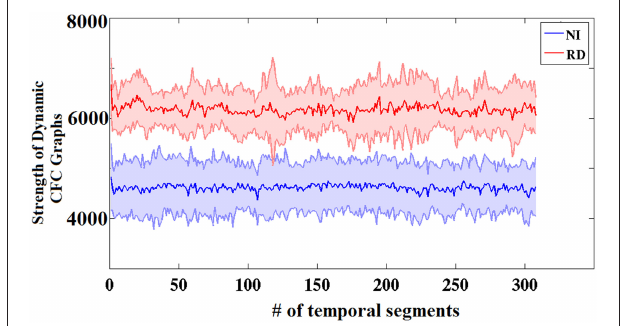
FIGURE 3 | Group-averaged strength of dynamic CFC graphs showing significantly greater overall strength in the RD compared to the NI group (Wilcoxon score, p < 10 − 13 ). The sums of PAC values over the entire network (between every possible pair of sensors) are plotted as solid lines surrounded by the corresponding ± 1 SD